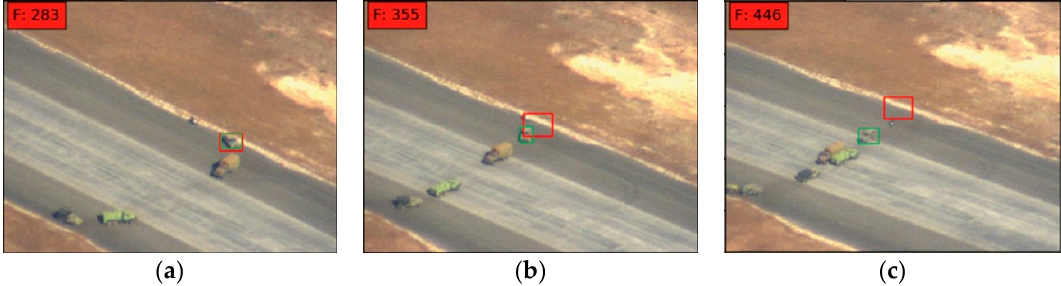
Figure 1. Example of false tracking due to target deformation: ( a – c ) are images to show tracking results for three frames in DARPA dataset, green boxes, ground truth; red, tracking